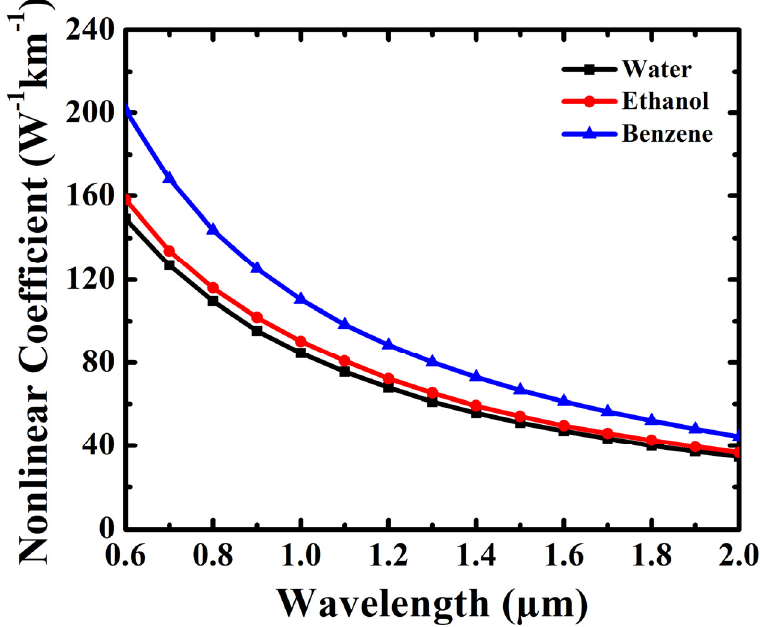
Figure 10. Nonlinear coefficient of the PCF sensor with water, ethanol and benzene, for different operating wavelengths.